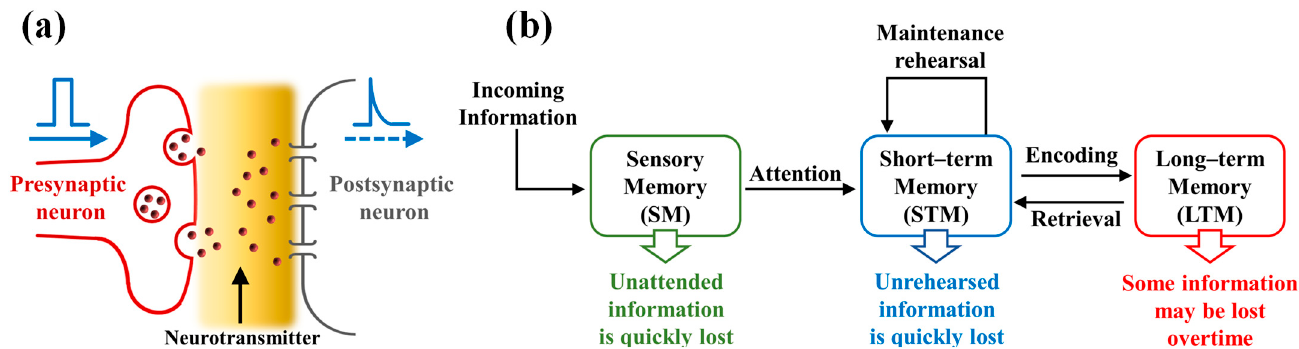
Figure 6. ( a ) Schematic diagram of a simplified biological synapse. ( b ) A typical learning and memory model describing short-term memory (STM) and long-term memory (LTM) behaviors in the brain.